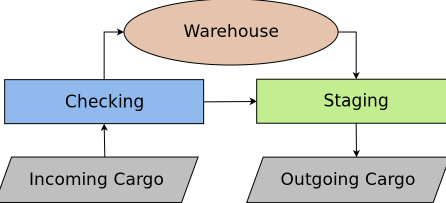
Figure 2. Summary of warehouse logistics process.